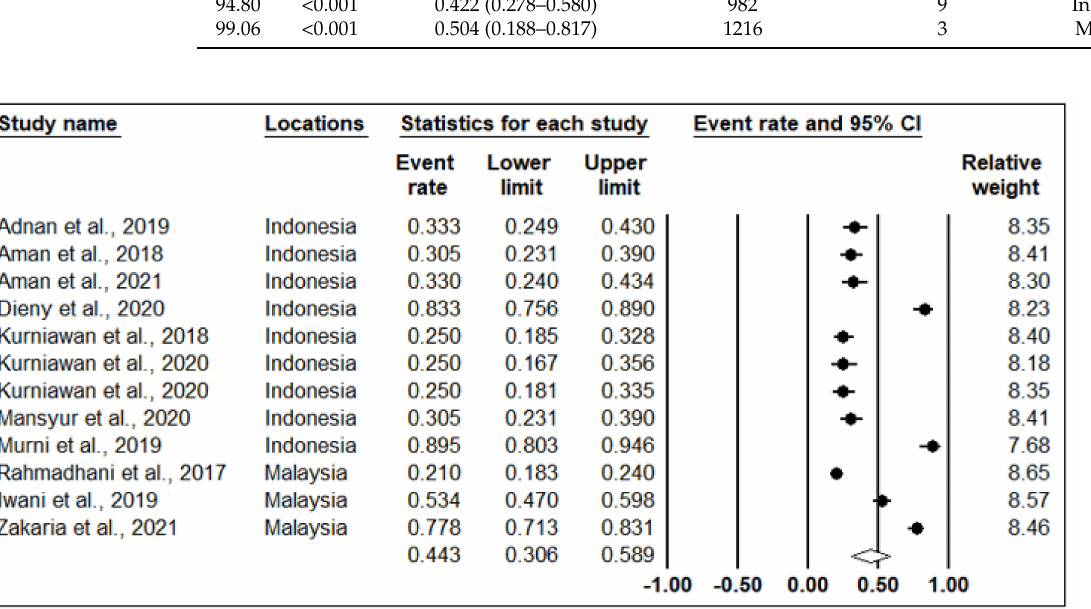
Figure 2. Forest plot of overall insulin resistance prevalence using random-effects model. The filled circle represents the prevalence rate of IR in each study. Unfilled diamond is the combined prevalence rate of IR